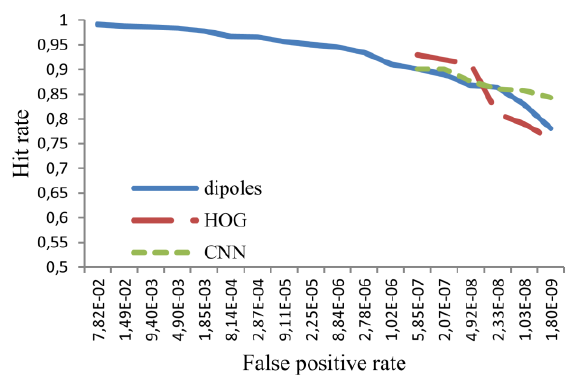
Figure 5: Comparison of different features and classifier used on the last stages of cascade for the blue squares type.